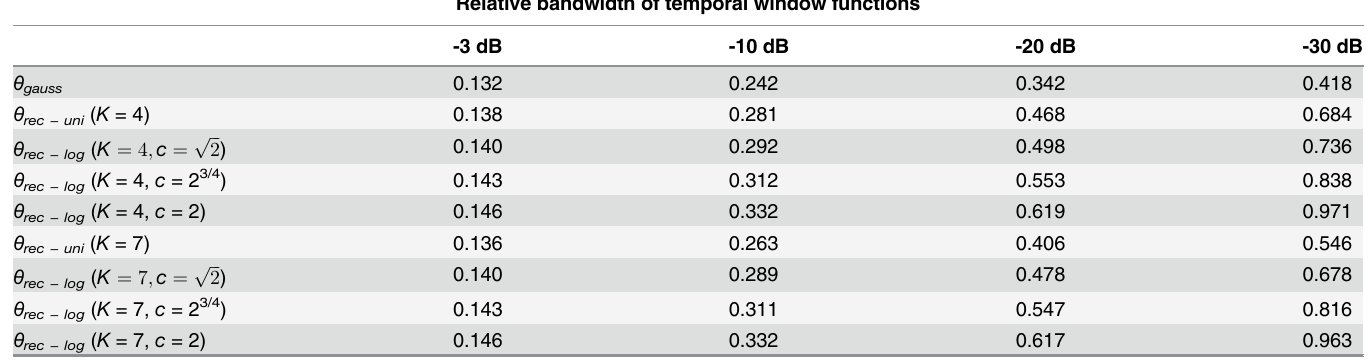
Table 1. Numerical values of the parameter θ determining the relative bandwidth 2 y and K truncated exponential kernels in cascade with a uniform distribution of the intermediate temporal scale levels τ k = τ / K or a logarithmic distri- bution τ k = c 2( k − K ) τ with c >